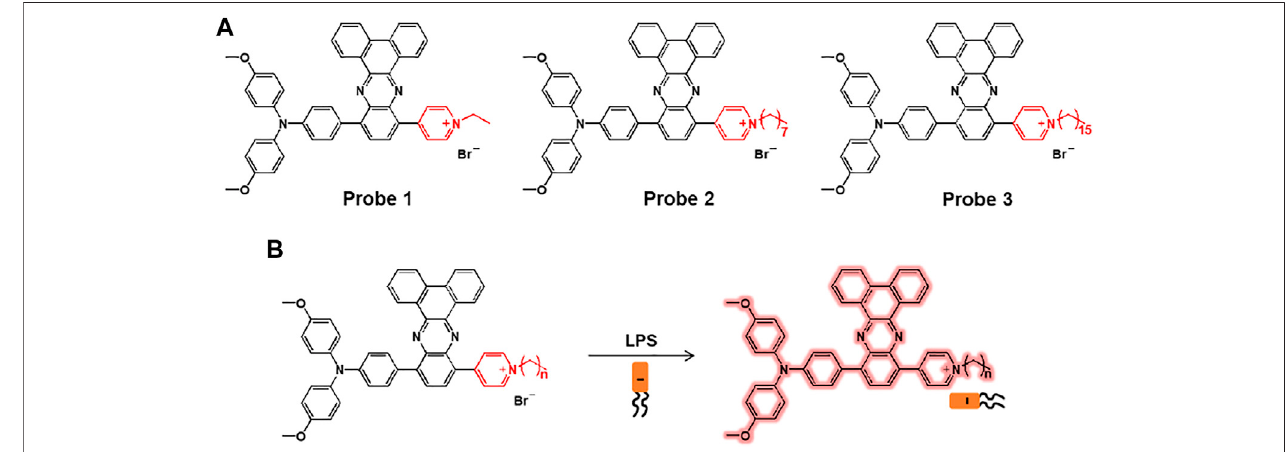
FIGURE 2 | (A) Chemical structures of probes 1 – 3. (B) Sensing mechanisms of probes for